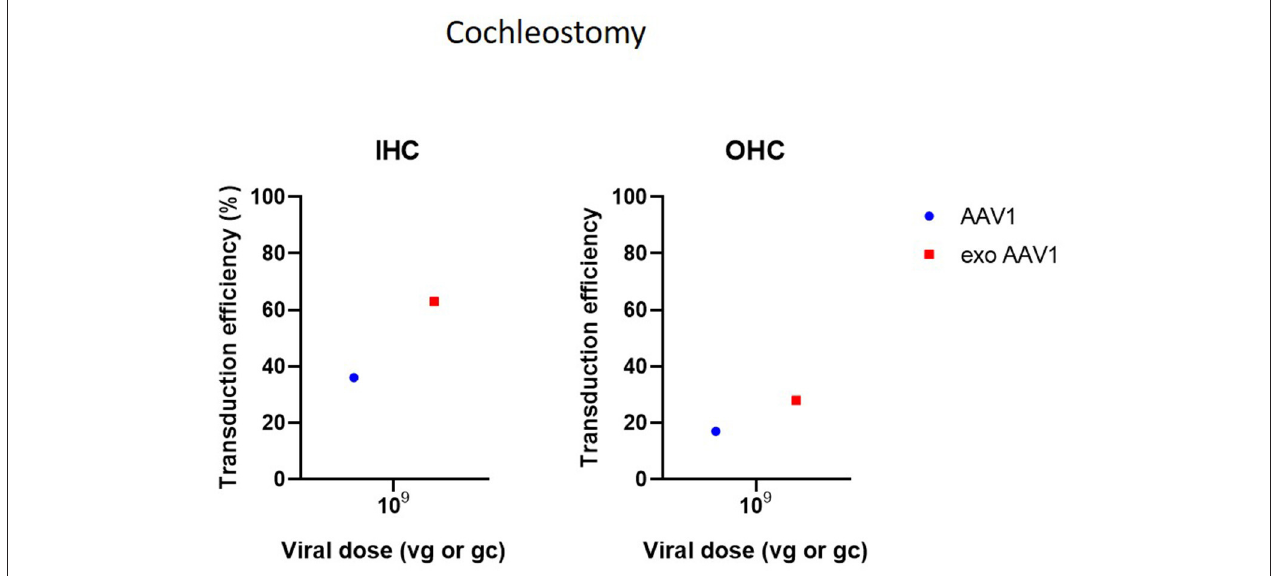
FIGURE 4 | Transduction efficiency of IHC and OHC according to viral vector dose using cochleostomy. Only data from studies that performed inner ear application of AAV in mice were used to plot these graphs. IHC, inner hair cell; OHC, outer hair cell; AAV, adeno-associated vector; gc, genome copies; vg, viral